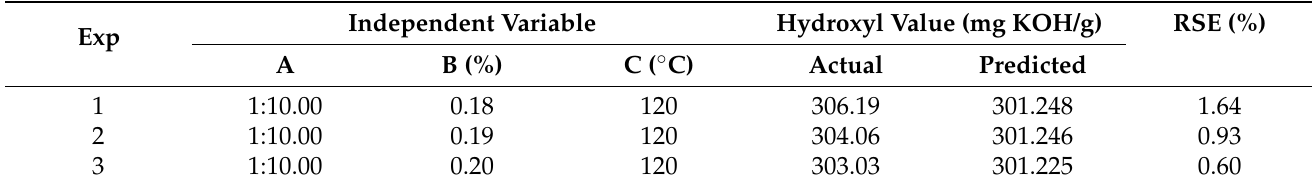
Table 5. Actual and predicted responses at optimum combinations.